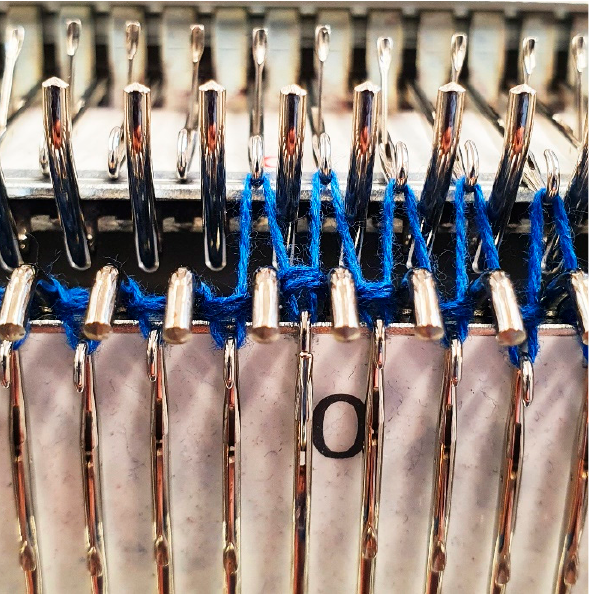
Figure 3. Close-up shot of the needle bed of a knitting machine, knitting a drop-stitch pattern. The vertical needles (hooks) are in the ribber bed, and the horizontal needles make up the main bed. The models were knitted with cotton yarns (2 × 20/2Ne, i.e., 2 strands of 2 ply 20 Ne knitted together), on a Silver Reed SK840 knitting machine (4.5 mm standard gauge; shown